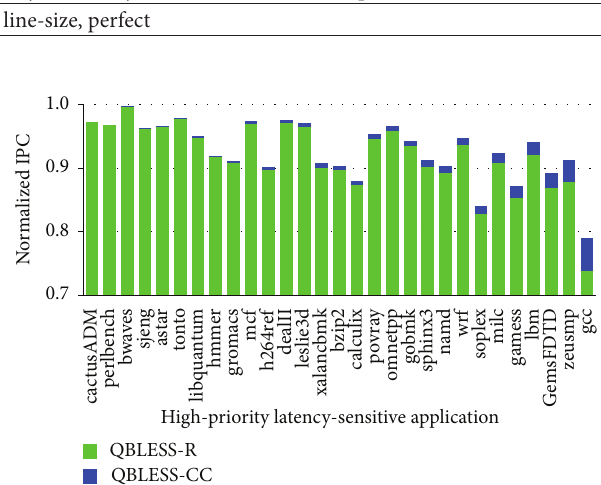
Figure 7: Performance of low-priority applications (normalized to BLESS).